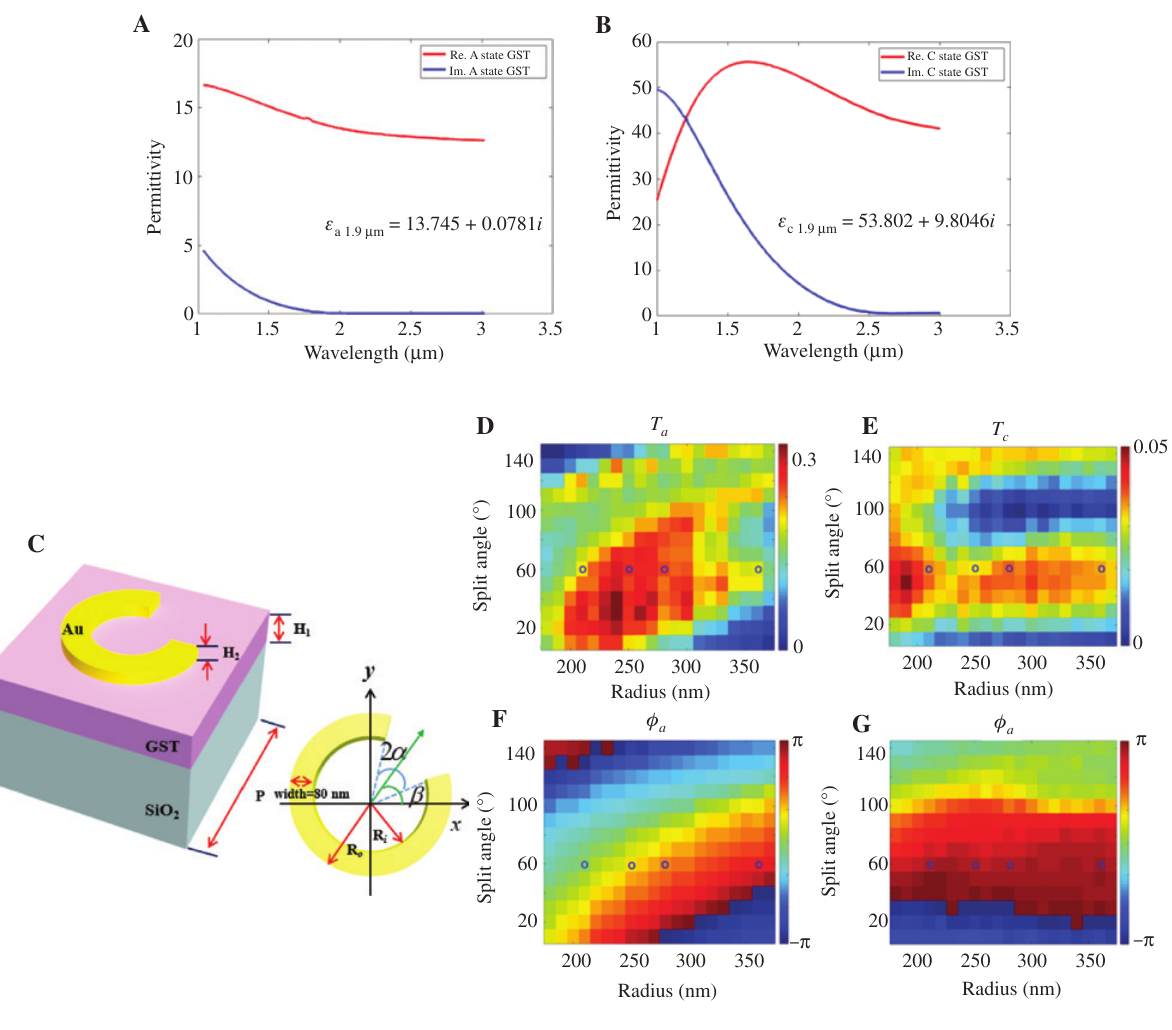
Figure 2: Structure parameters. (A) and (B) Values of A-state and C-state GST range from 1 μ m to 3 μ m. (C) Geometry of SRR within the unit cell. (D, E) Amplitude and (F, G) phase profiles of the cross-polarized transmission light under amorphous and crystalline states of the hybrid